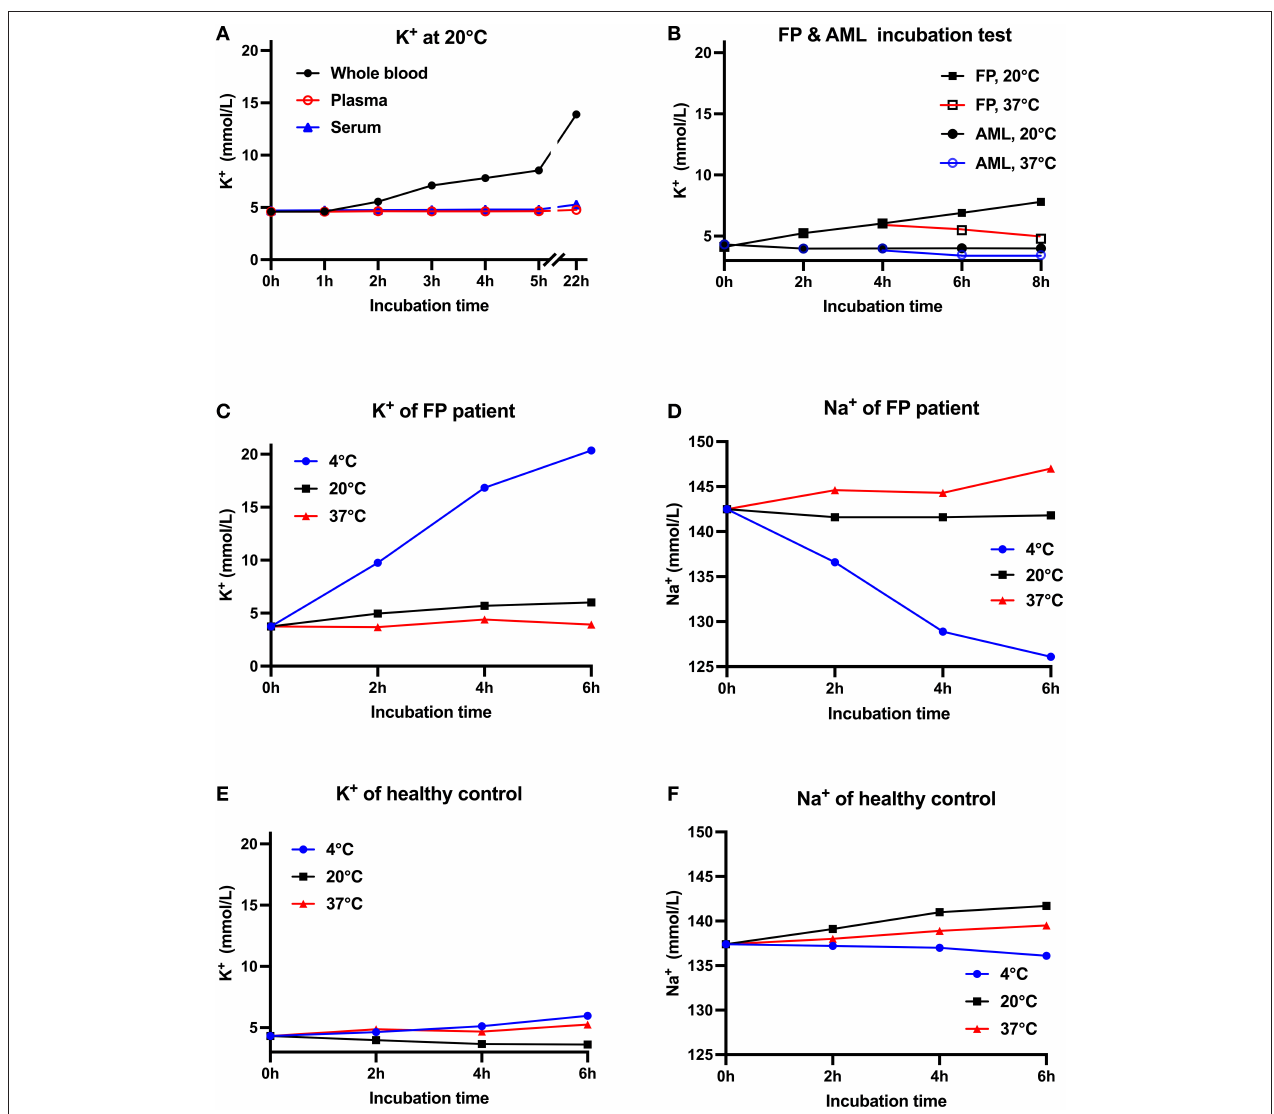
FIGURE 1 | Relationship between K + concentration, blood sample types and storage temperatures. (A) Reassessment of the patient’s potassium levels at 1, 2, 3, 4, 5, and 22h after blood collection. Baseline K + concentration in whole blood, plasma and serum samples was normal. Whole blood K + increased with storage time, while isolated plasma and serum K + showed minor changes at 20 ◦ C. (B) Two whole blood samples from the patient and two samples from AML patients were first stored at 20 ◦ C for 4h and then respectively stored at 20 ◦ C or 37 ◦ C. This patient’s blood K + gradually increased at 20 ◦ C but decreased at 37 ◦ C, while AML patients’ K + basically remained unchanged (C–F) . K + & Na + concentration from the FP patient’s (C,D) and healthy control’s (E,F) blood samples stored at 4, 20, and 37 ◦ C. Compared with healthy controls, the FP patient’s measured K + increased dramatically at 4 ◦ C, while potassium at 20 and 37 ◦ C merely showed slight fluctuations. All tests were conducted once. AML, acute myeloid